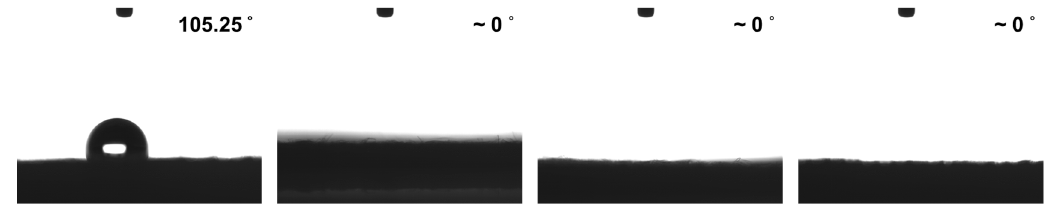
Figure 4. Water contact angle measurement results of APPJ-processed rGOs on carbon cloth.